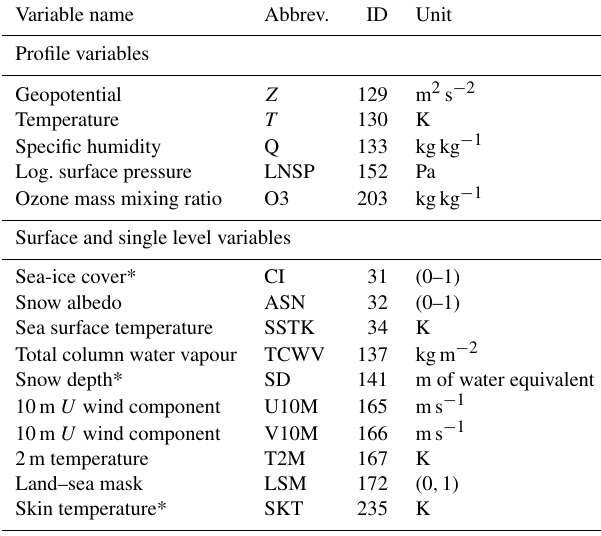
Table A1. ERA-Interim variables used within CC4CL. Variables marked with * are available at 0.1 ◦ spatial resolution; all others default to 0.72 ◦ .